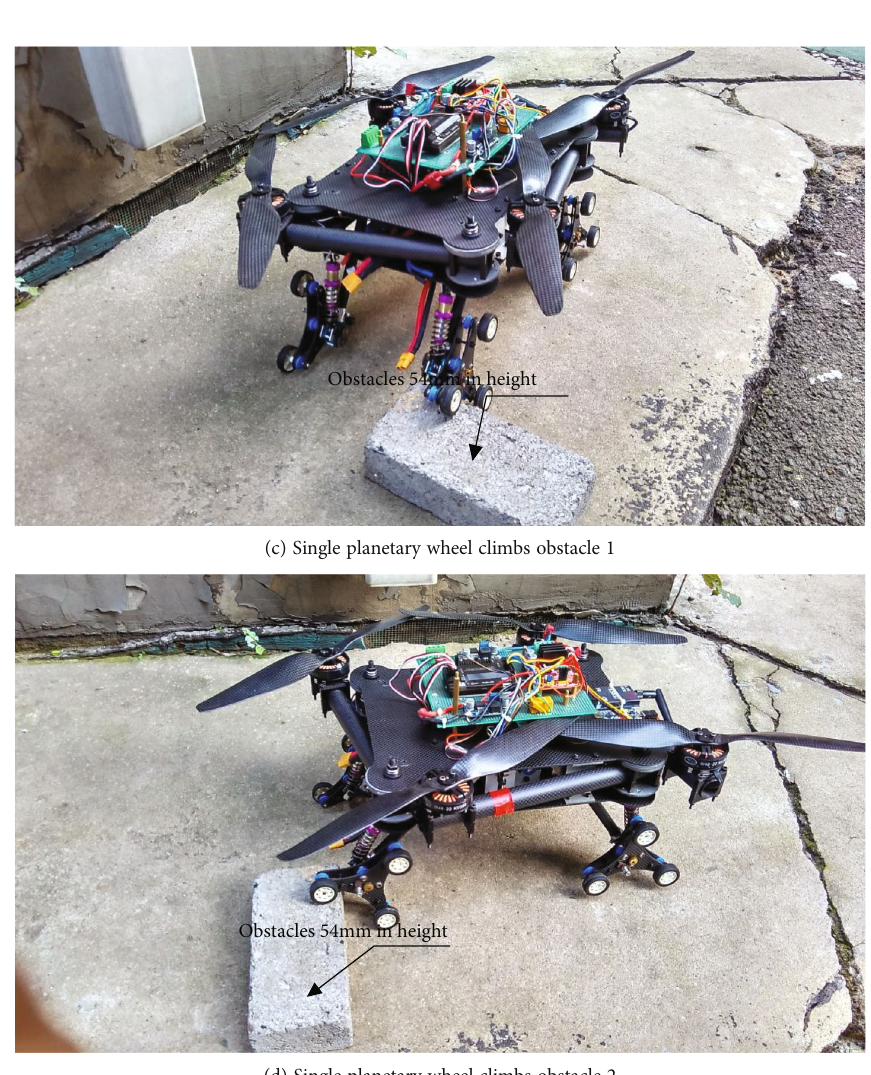
Figure 10: Experiment verifying the robot ’ s overstepping